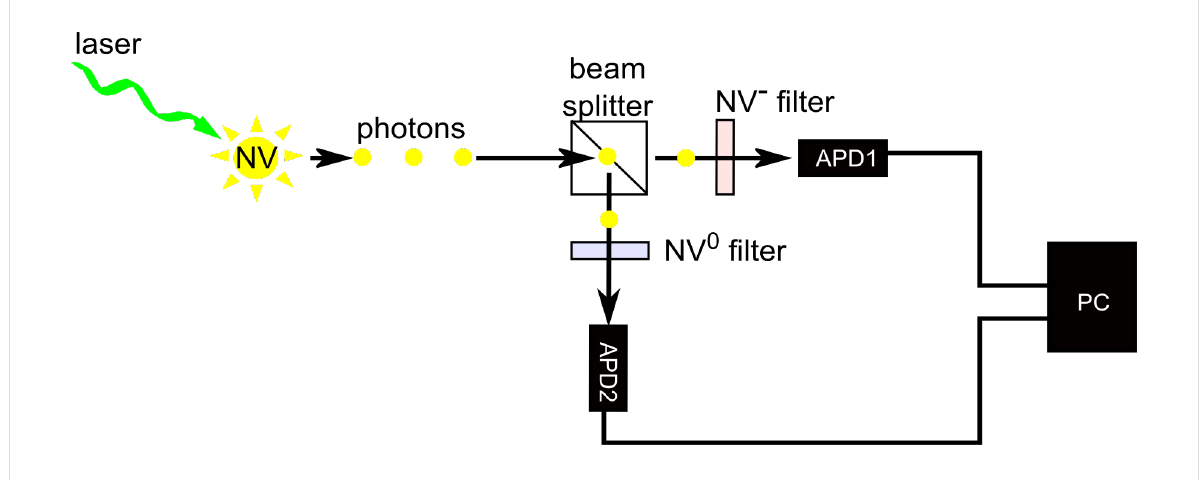
Figure 4: Schematic setup for time-resolved measurement of NV-intensity. To record the time evolution of the intensity of NV − and NV 0 emission during switching between NV − or NV 0 and NV + , the single NV centre was illuminated continuously with a 520 nm laser during the switching cycles and the emitted NV-photoluminescence was routed via a beam splitter to two avalanche photo diodes with corresponding NV filters in front of them.